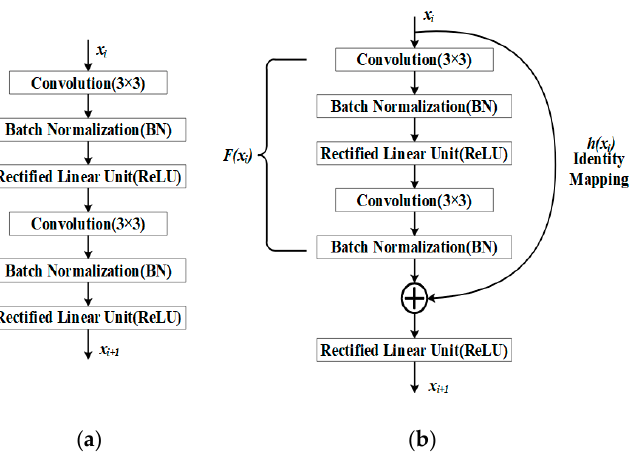
Figure 3. The difference between the common neural network unit and the residual neural network unit: ( a ) Common neural network unit; ( b ) Residual neural network unit.